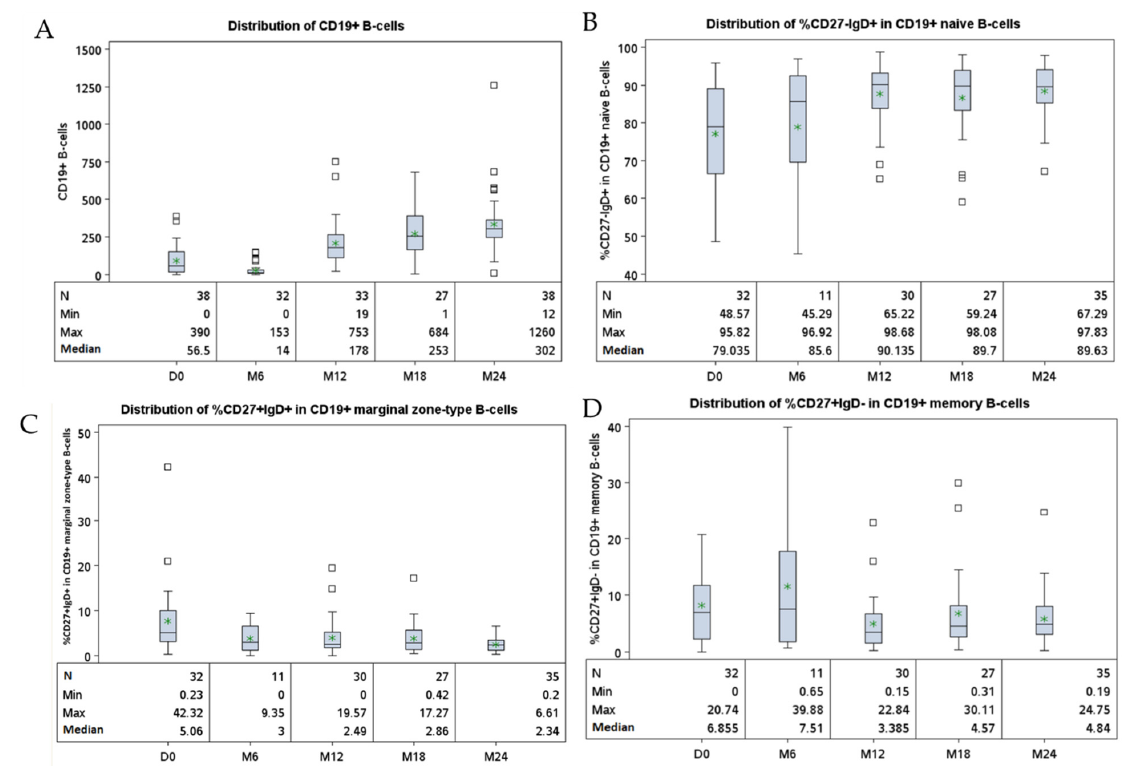
Figure 2. Longitudinal distribution of lymphocyte subsets in HIV- cHL patients. Legend: The panels represent the distribution of CD19 + cell counts (cells/ µ L) ( A ) and, among total B-cells, the proportions of naive ( B ), marginal zone type ( C ) and memory cells ( D ) collected every 6 months for 24 months starting from cHL diagnosis. *: mean; D: day; M: